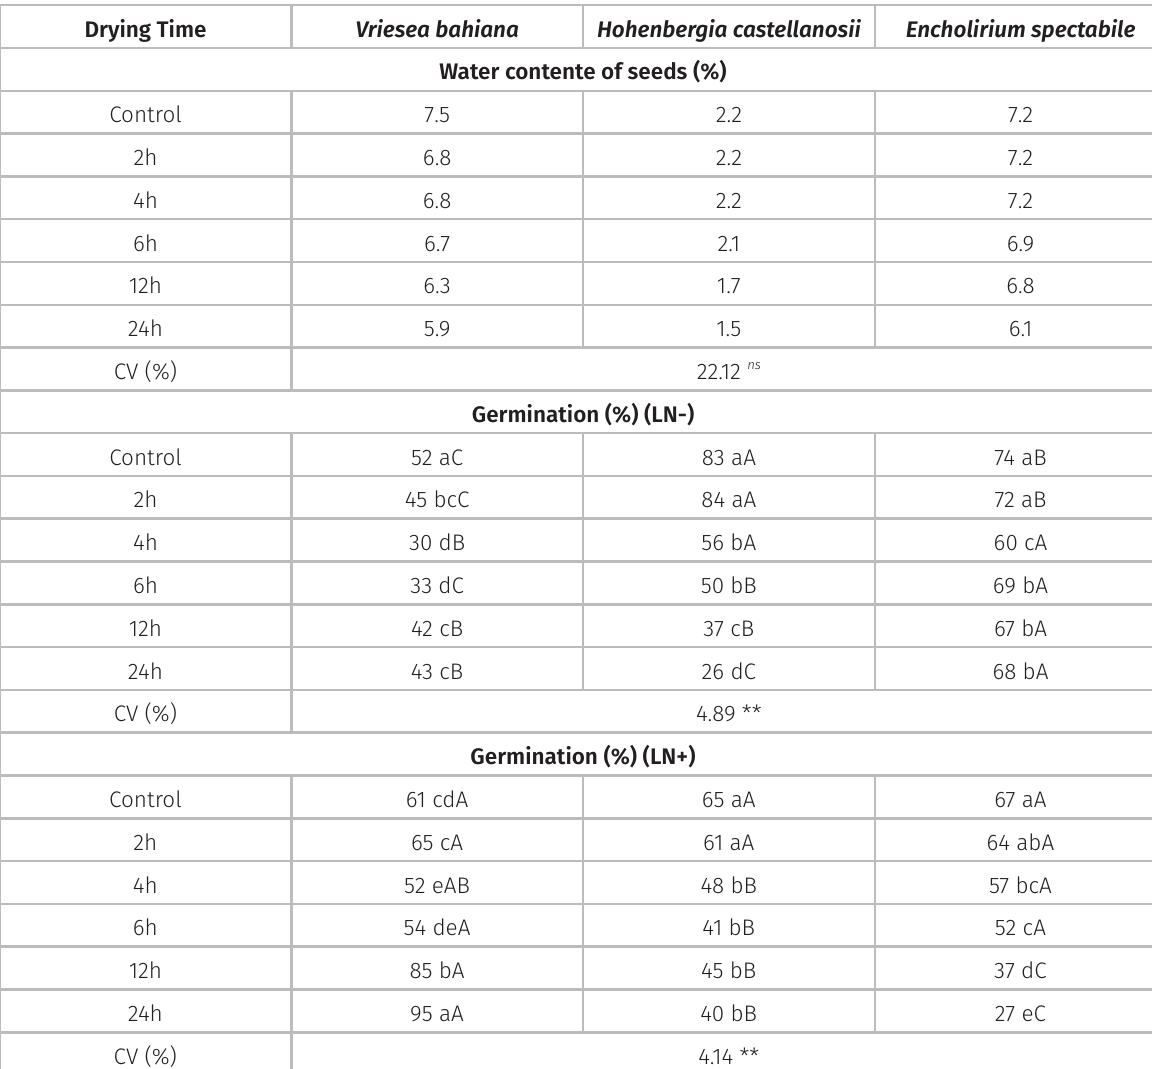
Table III. Water content, germination percentage after desiccation and freezing in liquid nitrogen of seeds of Vriesea bahiana, Encholirium spectabile and Hohenbergia castellanosii. Vriesea bahiana Hohenbergia castellanosii Encholirium